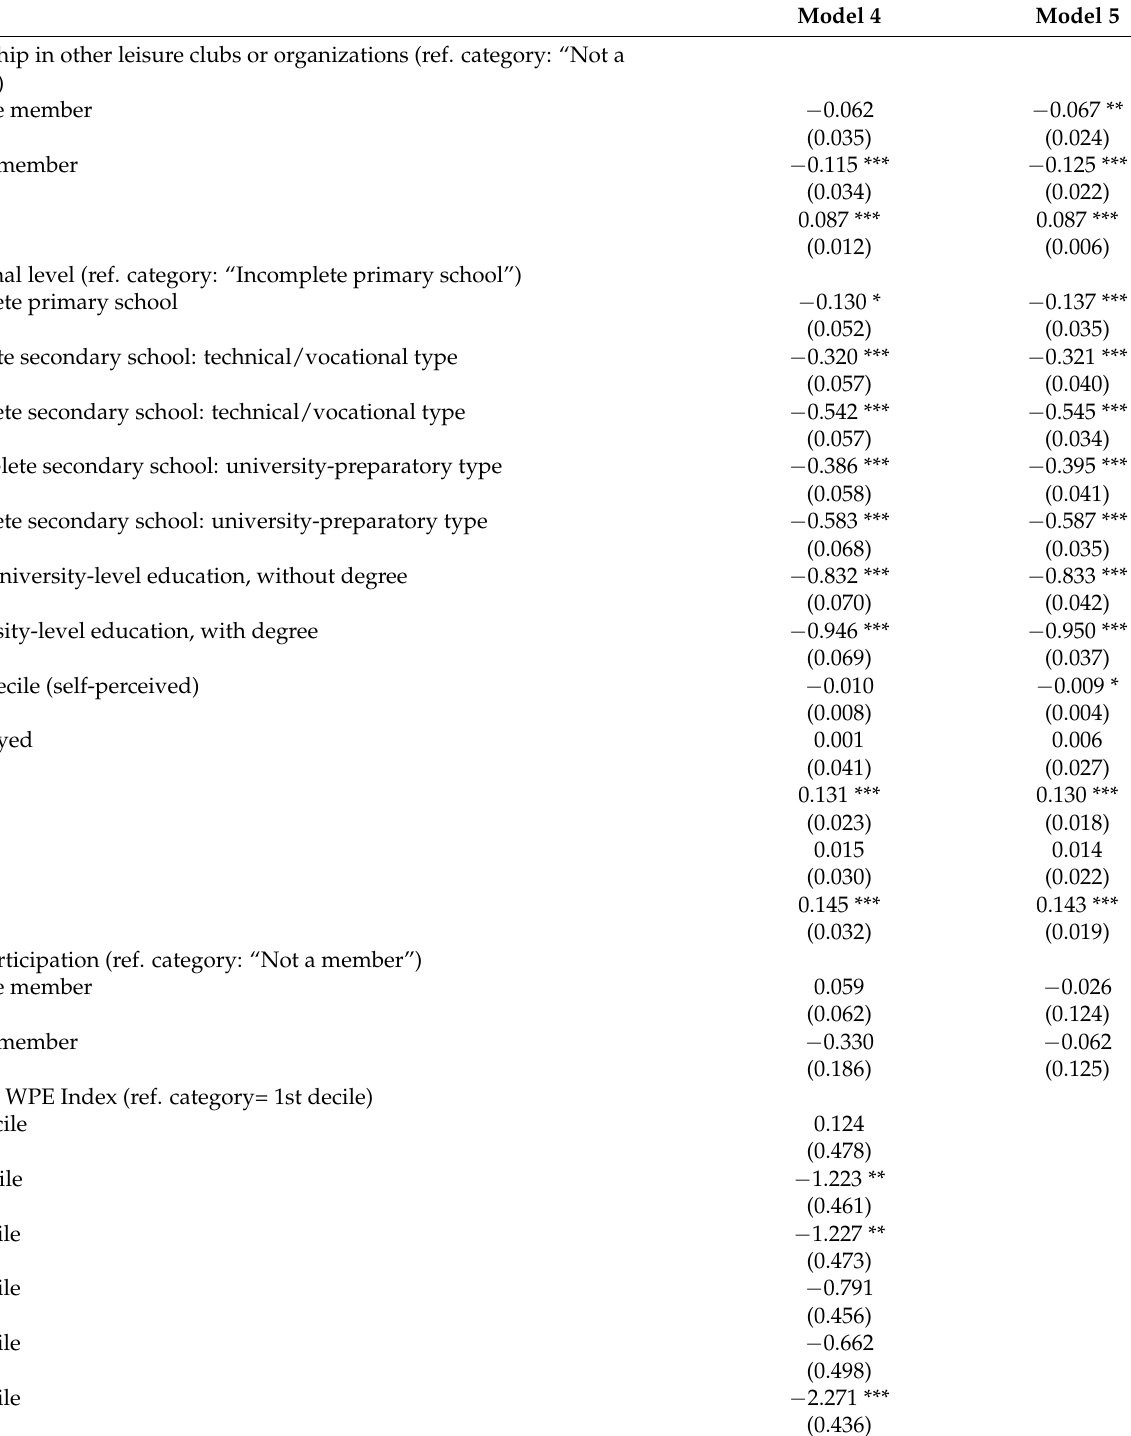
Table A6. Partial effects of sports participation on sexist gender ideologies moderated by the deciles of the WPE Index (Model 4), respectively, on the deciles of the EG Index (Model 5). Random coefficient models based on female observations from 74 countries. Source: WVS-EVS-data and V-Dem